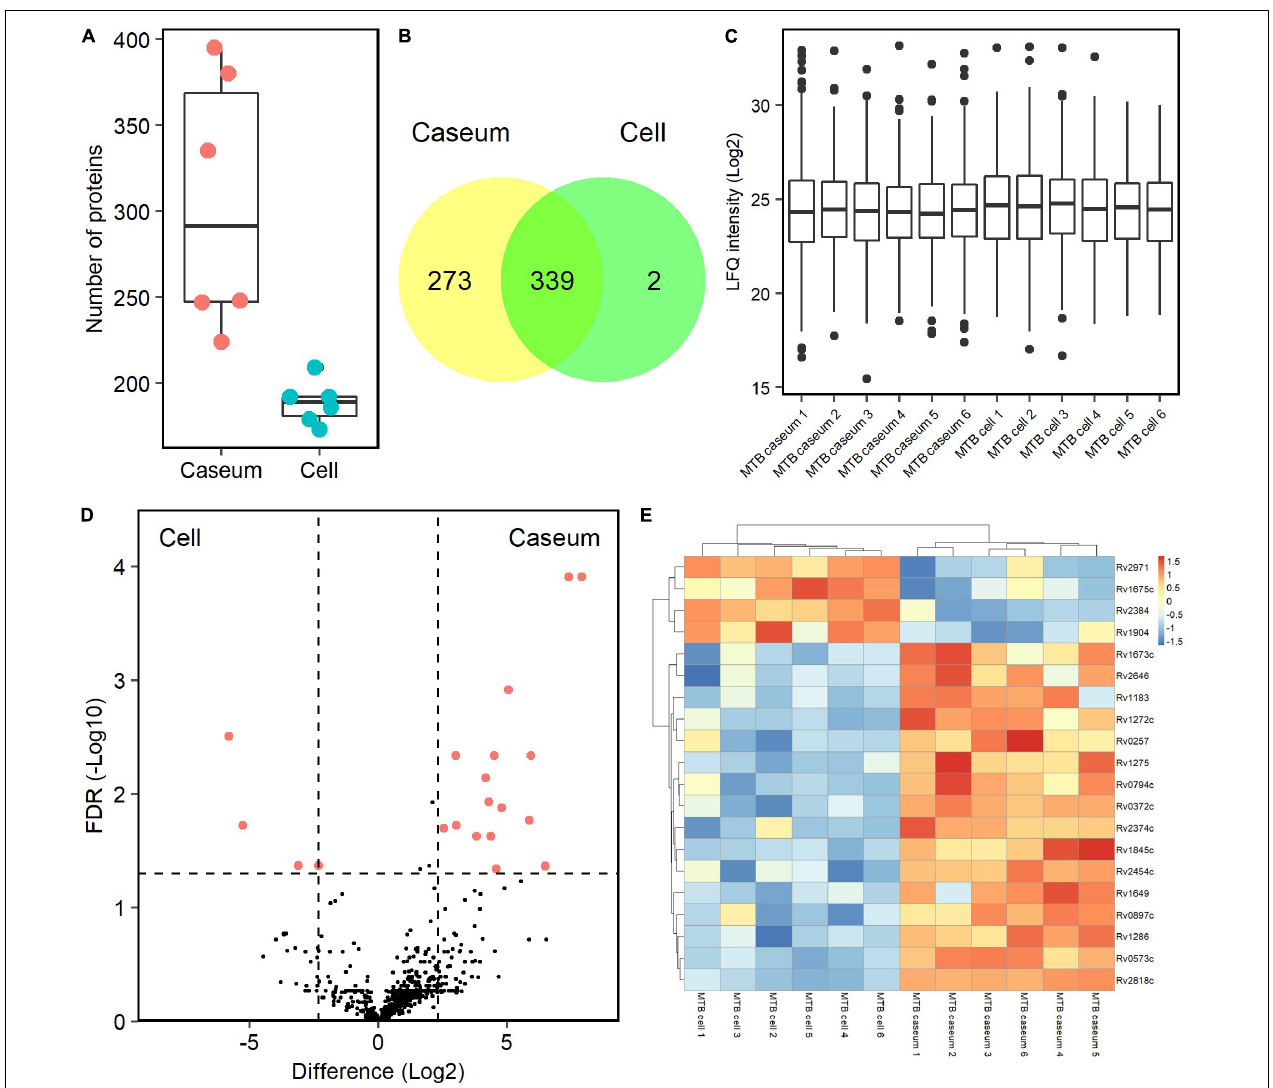
FIGURE 7 | Proteomic profiling of proteins derived from M. tuberculosis in granulomatous lesions. (A) Boxplot of the number of identified M. tuberculosis proteins with LFQ values from MTB granulomatous sub-compartments. Bold lines indicate the median of identified number in the granulomatous sub-compartments, a box captures 50% of the measurements, and whiskers span values of the 5–95% interval. The protein number identified in each sample is also plotted. (B) Venn diagrams comparing the number of identified M. tuberculosis proteins in granulomatous lesions. The numbers of proteins detected in at least one sample among sub-compartments are indicated. (C) Boxplot of LFQ intensity values of identified M. tuberculosis proteins in samples. Bold lines indicate the median of log 2 -transformed LFQ intensity values, a box captures 50% of the measurements, and whiskers span values of the 5–95% interval. Outliers are shown as dots. (D) Volcano plot of protein abundance of identified M. tuberculosis proteins between TB granulomatous sub-compartments. The logarithmic ratios of average fold changes and negative logarithmic FDR values of the Welch’s t -test between samples from caseous and cellular sub-compartments are plotted on the x- and y- axes, respectively. Highlighting dots correspond to M. tuberculosis proteins with significantly different abundance (FDR < 0.05 and absolute value of fold change > 5). (E) Hierarchical-clustering-based heat map for M. tuberculosis with different abundance between the sub-compartments of TB granulomatous lesions ( n = 20). Names of M. tuberculosis proteins with significantly different abundance are